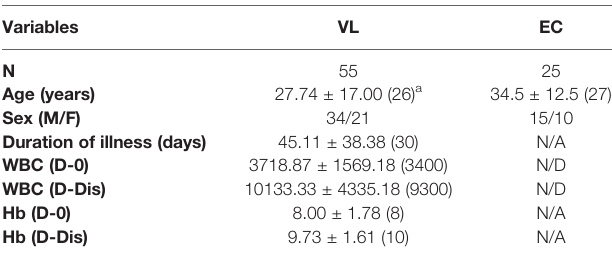
TABLE 1 | Demographic and clinical details of the study